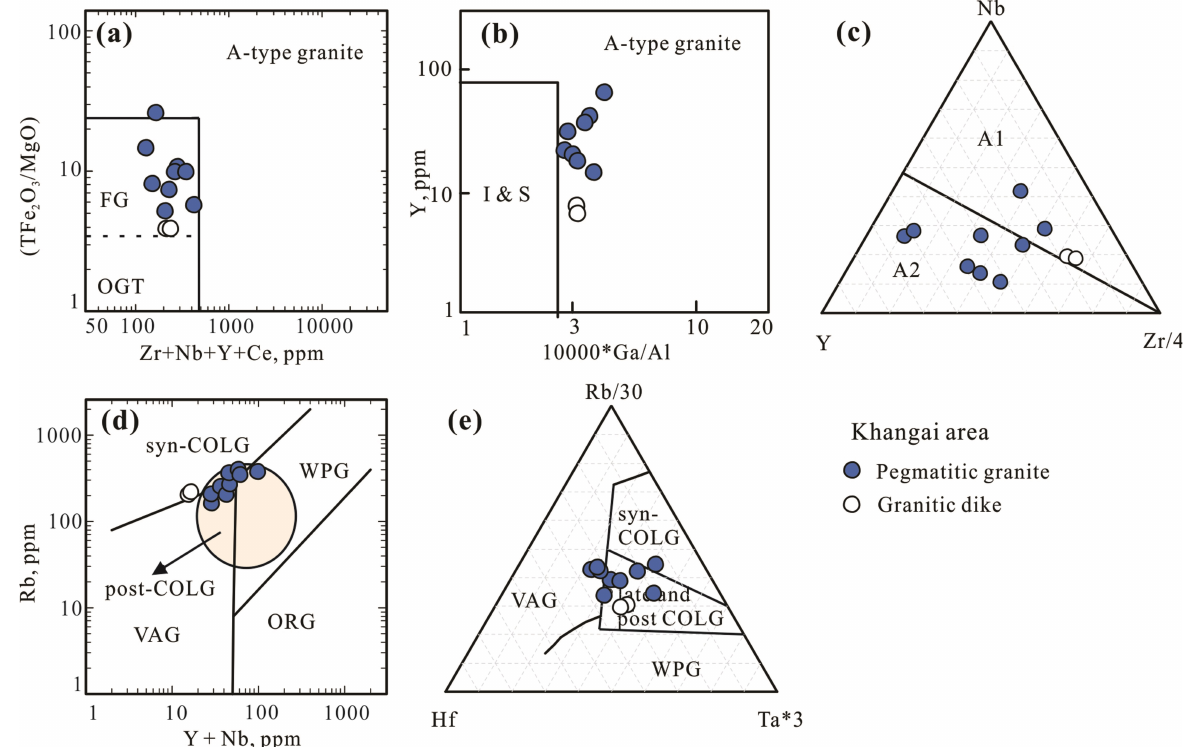
Fig. 10. Diagrams showing granitic rocks from the Khangai area plotted on tectonic discrimination diagrams. (a) TFe O /MgO vs. (Zr + Nb + Y + Ce) diagram after Whalen et al. (1987). (b) Y vs. 10000*Ga/Al diagram 2 3 discriminating between I-, S-, and A-type granites after Whalen et al. (1987). (c) Ternary Y vs. Nb vs. Zr/4 diagram after Eby (1992). (d) Rb vs. (Y + Nb) diagram after Pearce et al. (1984). (e) Ternary Hf vs. Rb/30 vs. Ta*3 diagram after Harris et al. (1986). Abbreviations are as in Figs 6 and 9 with A1 = intraplate rifting and A2 = post-collisional, I-igneous,